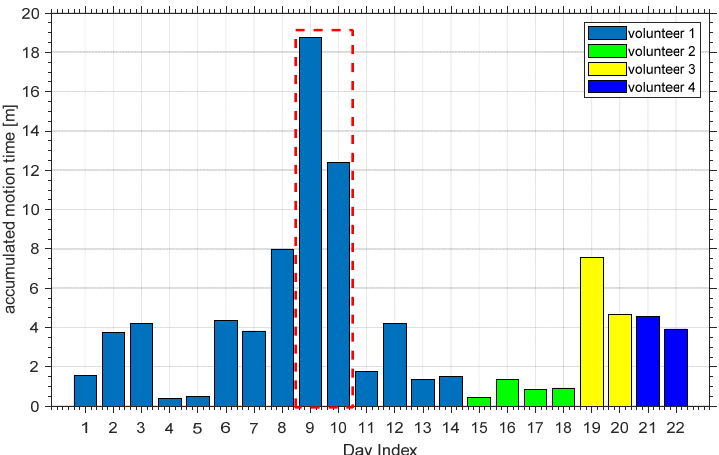
Figure 24. The instantaneous activity intensity and the motion status during sleep of volunteer 1. For an individual subject, it is true that the body movement during sleep over one night cannot tell if the subject sleeps well or not, however, the body movement pattern over weeks or months could be a good indicator for one’s sleep quality (especially for very abnormal patterns). In this paper, we used the accumulated body movement time during sleep to represent the body movement frequency. Figure 25 shows the accumulated mo- tion time during sleep of all the volunteers, the first 14 days are the accumulated motion time of volunteer 1. Only consider volunteer 1, we can find that during the 14 days, the accumulated motion time in the ninth and tenth day are much longer than the other twelve days. Through compared with the corresponding ground-truth video, we can find that the volunteer 1 suffered from insomnia for some reason in those two nights.